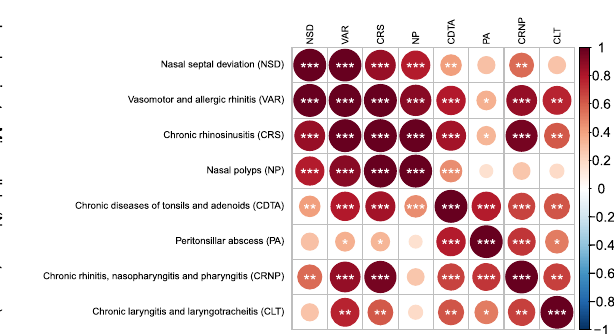
Fig. 1 | Shared heritability among in fl ammatory and infectious upper respira- tory diseases (IURDs). A (left): effect sizes of lead variants of 24 non- HLA loci across IURD phenotypes. Red indicates a positive and blue a negative effect size estimate(inlog-odds)usinglogisticregression(Methods). P valueswerecalculated usinguppertailchi-square testing (onedegree of freedom)fromat-statisticunder a normal approximation. Variants and phenotypes are ordered according to hier- archical clustering (Methods). The clusters show shared genetic heritability for variant clusters between recognized phenotype groups of sinonasal (NSD, VAR,